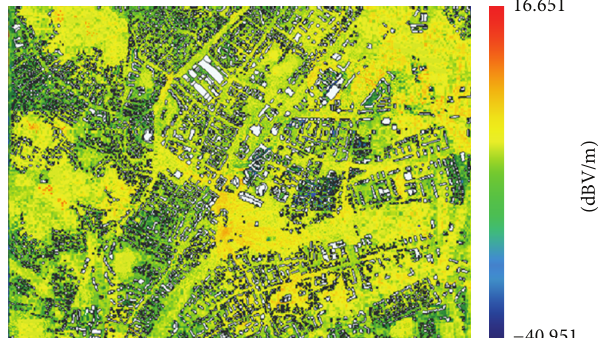
Figure 9: Deviation and logarithmic quotient of predicted and measured values of total electric field strength.